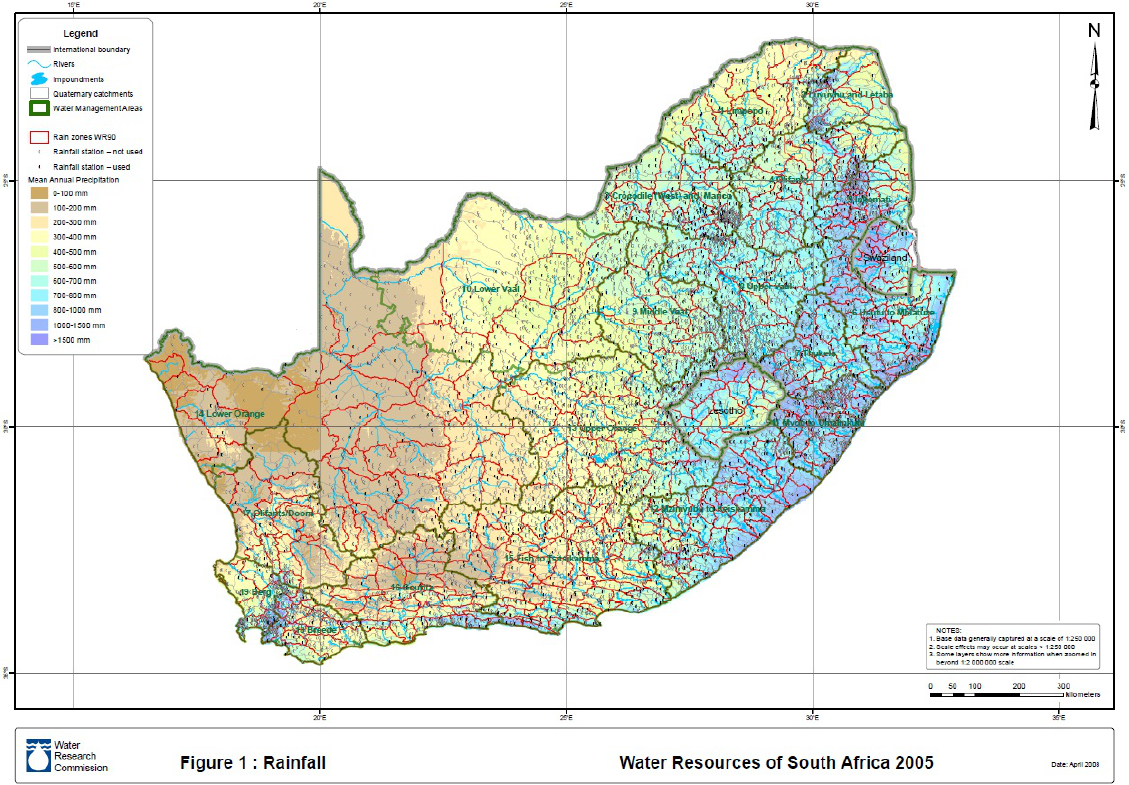
Illustration 1: Map showing distribution of rainfall in South Africa.